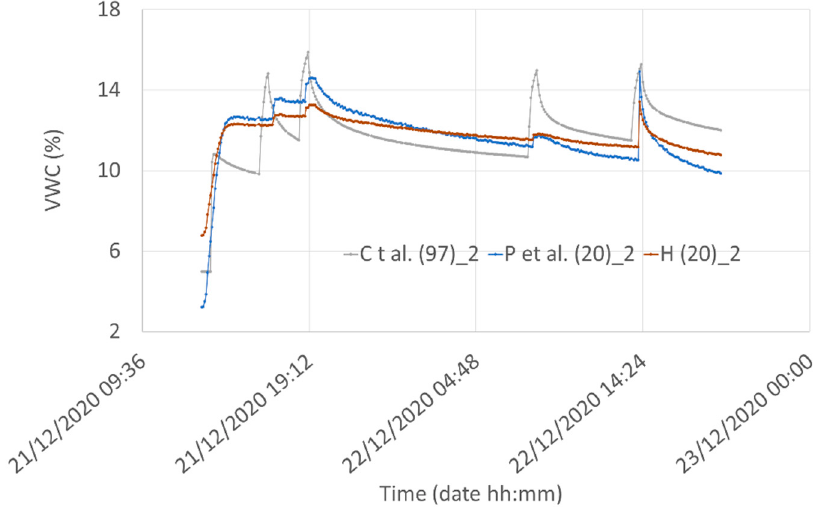
Figure 24. Comparison among the best results obtained from the correlation procedure for the three considered models.